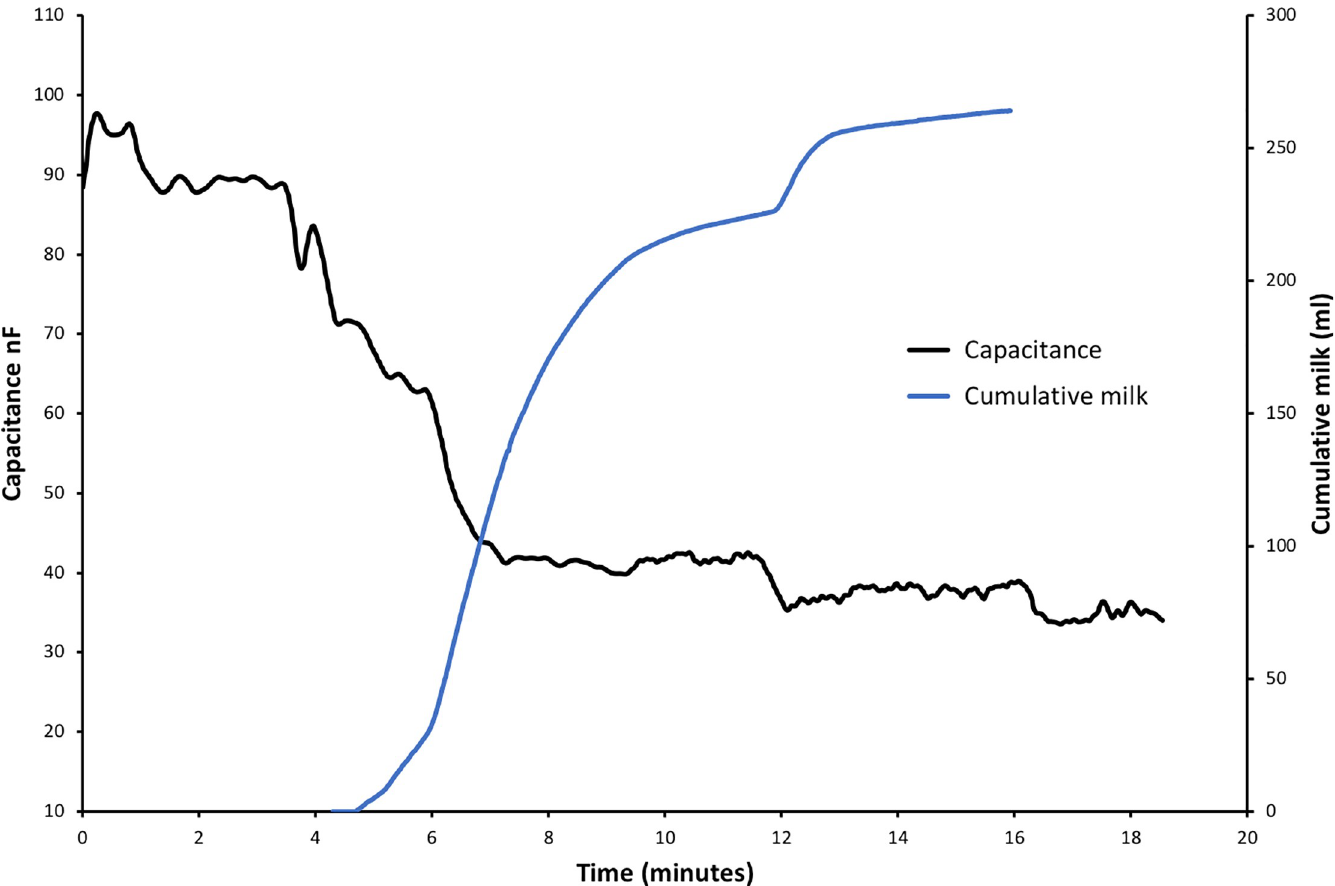
Fig 4. The inverse relationship between membrane capacitance and cumulative milk removed for a typical pumping